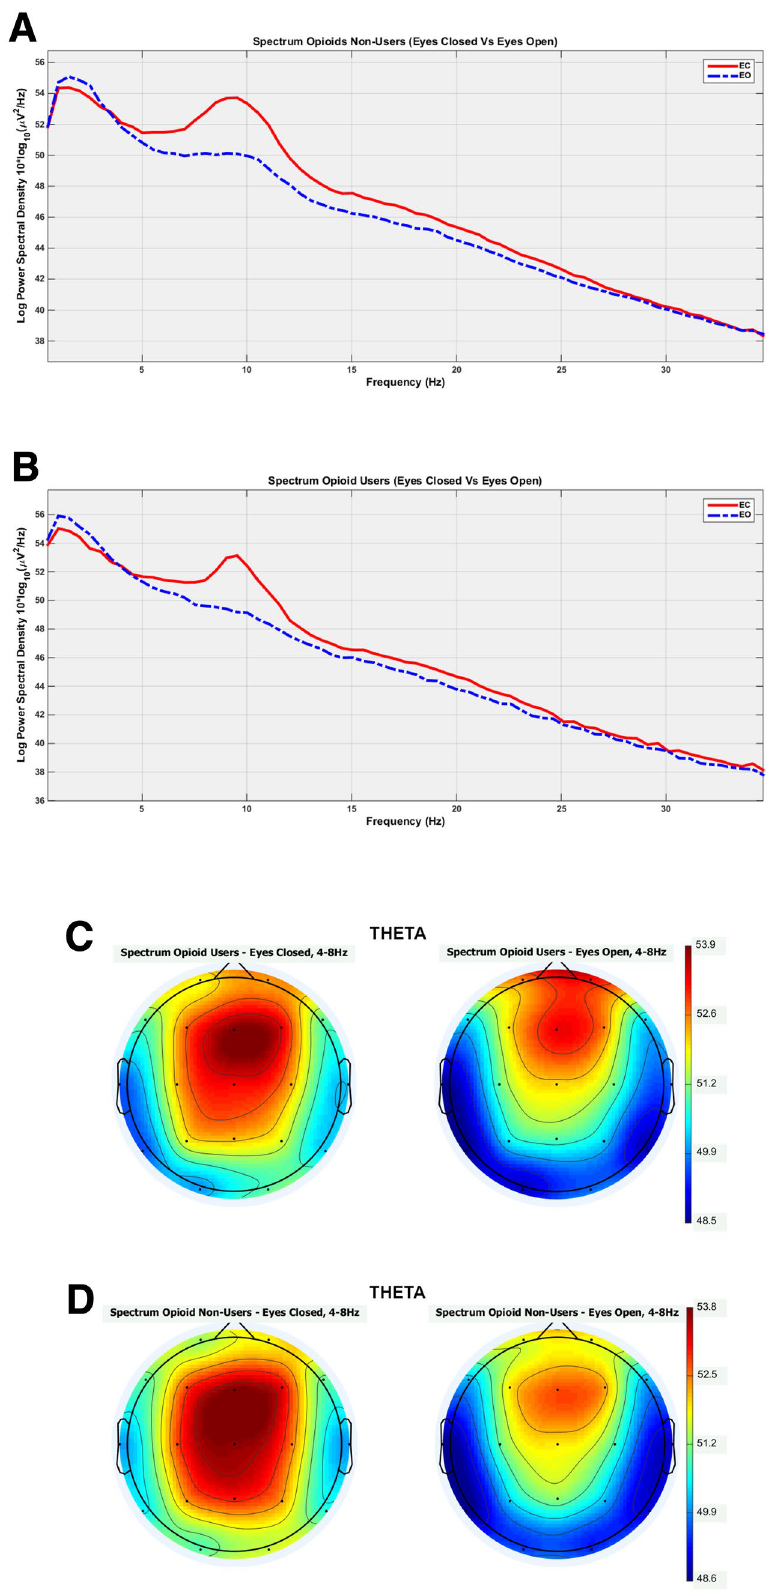
Figure 2. Spectral power density (SPD) to eyes close and eyes open states to opioid users ( A ) and opioid non-users ( B ). It shows significantly higher peak amplitudes for theta EC state compared to EO state for the non-opioid non-users. For opioid use groups, higher peak amplitudes for the EC state occur only in alpha band frequencies. Scalp topography maps for resting state for eyes closed (EC) and eyes open (EO) in the theta frequency bands to opioid users ( C ) and opioid non-users ( D